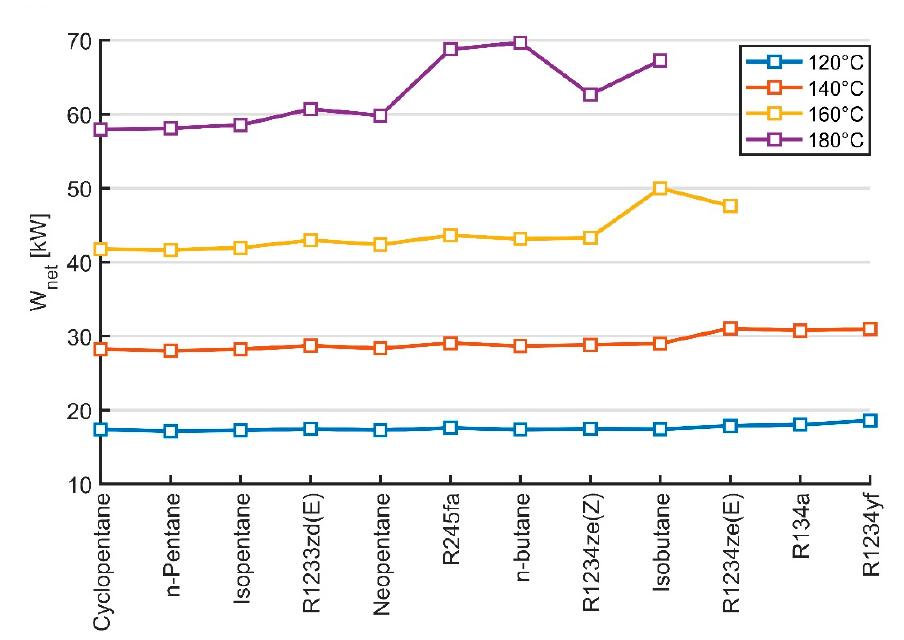
Figure 4. The net power output of the DP ORC configuration, as a function of the working fluids, for the geothermal heat source characteristic temperatures.